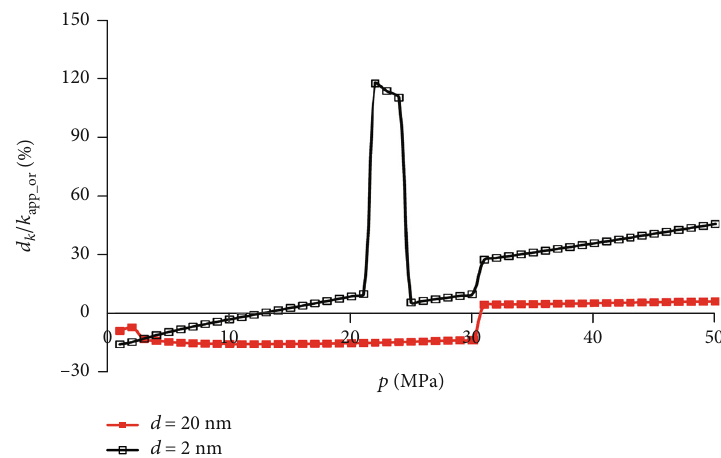
Figure 8: Curves of the ratio of change in the AGP to the AGP in the organic pore without considering the real gas e ff ect.